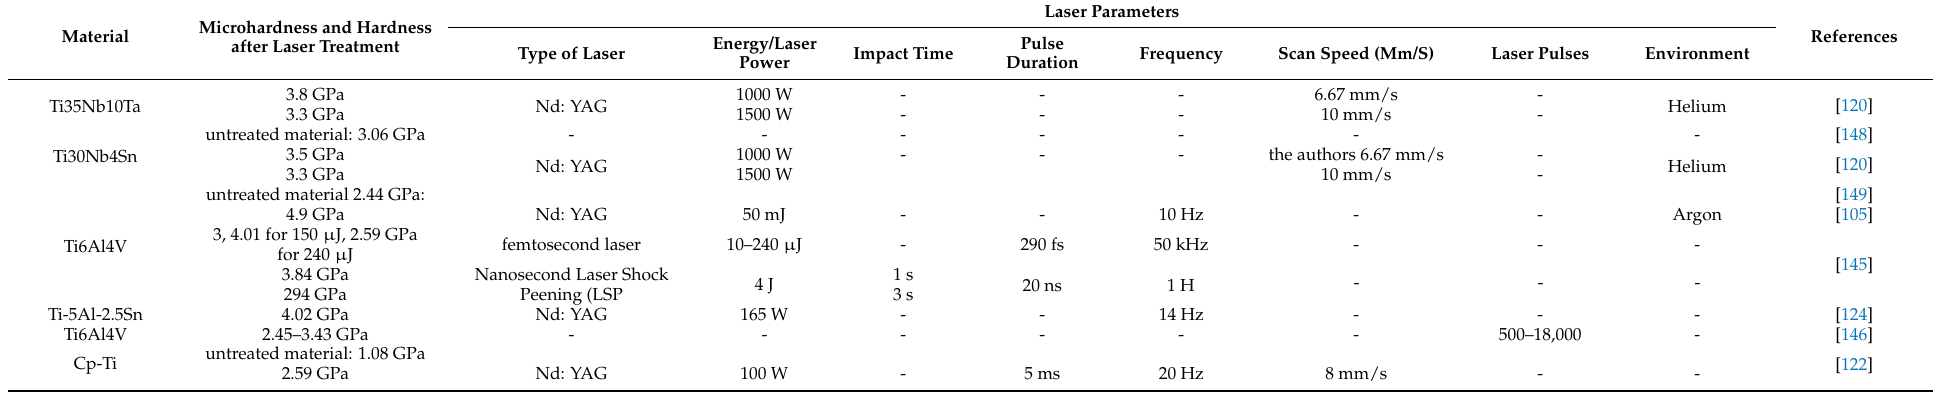
Table 4. Microhardness and hardness after laser treatment on titanium and its